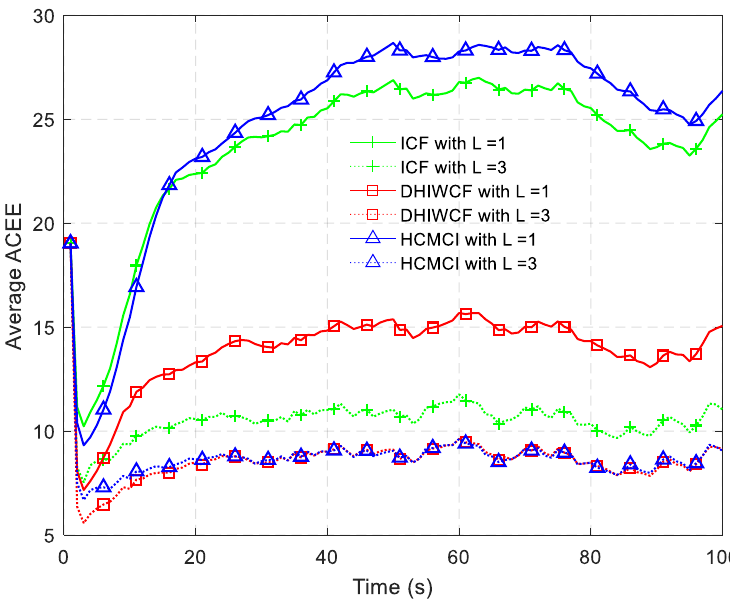
Figure 12. The average ACEE for distributed algorithms under discussion.